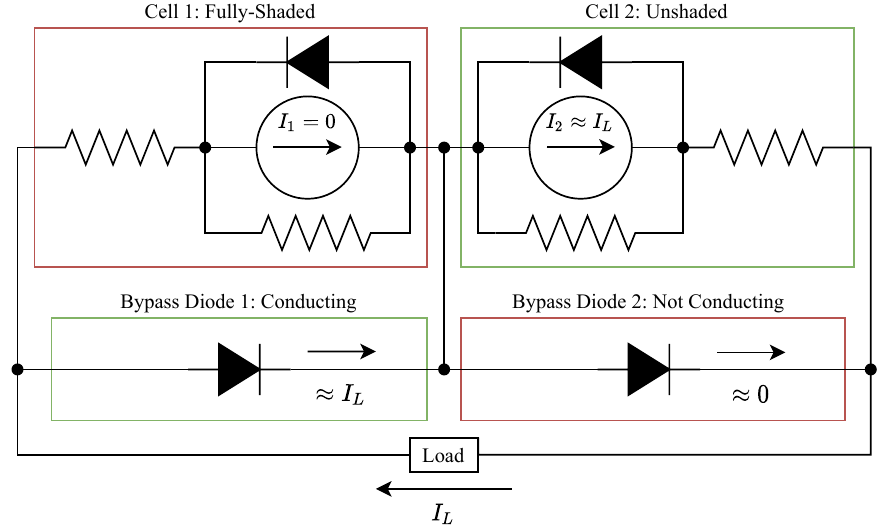
Figure 3. Bypass diode operation in a PV system composed of two series-connected PV cells with differing solar irradiance.